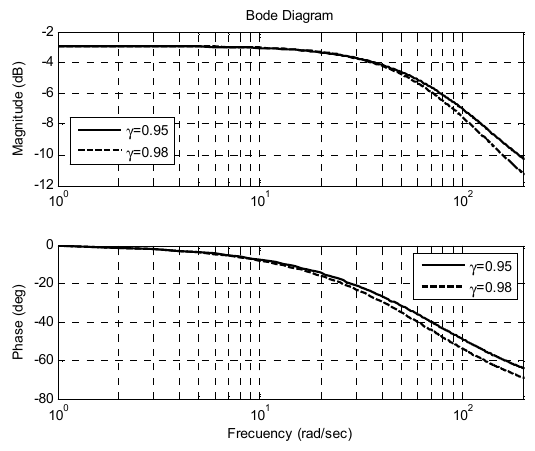
Fig. 5: Bode diagram corresponding to the first layer, fractional exponent γ =0.95